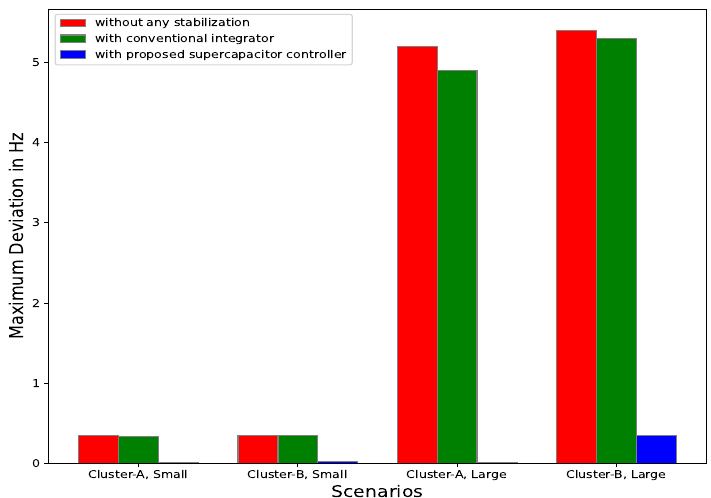
Figure 16. Frequency response for all disturbance scenarios applied in cluster